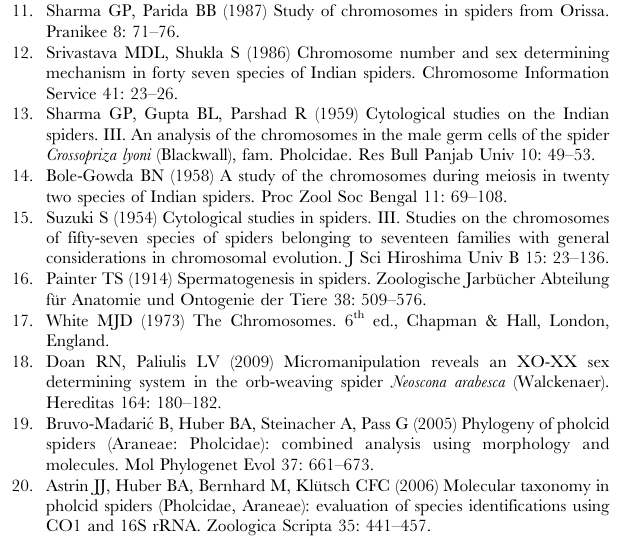
types in Figure 1. A. Giemsa-stained spread of Physocyclus mexicanus metaphase II spermatocyte used to derive karyotype in Figure 1A, with eight chromosomes. Arrow points to X chromosome. Bar = 10 m m. B. Giemsa-stained spread of Holocne- mus pluchei metaphase II spermatocyte used to derive all